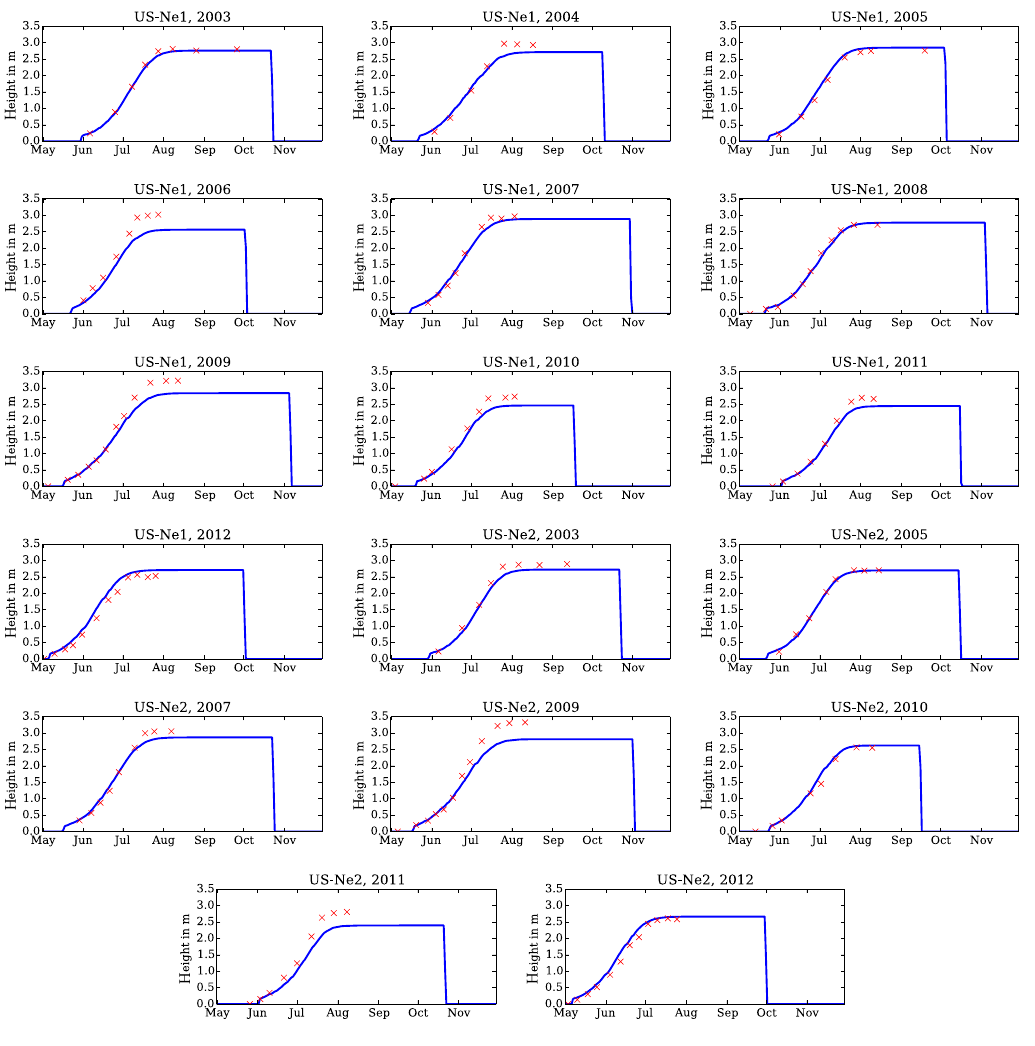
Figure 25. Time series of canopy height for irrigated maize at the Mead FLUXNET sites US-Ne1 and US-Ne2; blue: model; red: observa- tions. JULES runs have the crop model switched on and the input parameters in Tables 1, 2, 3, and 4.